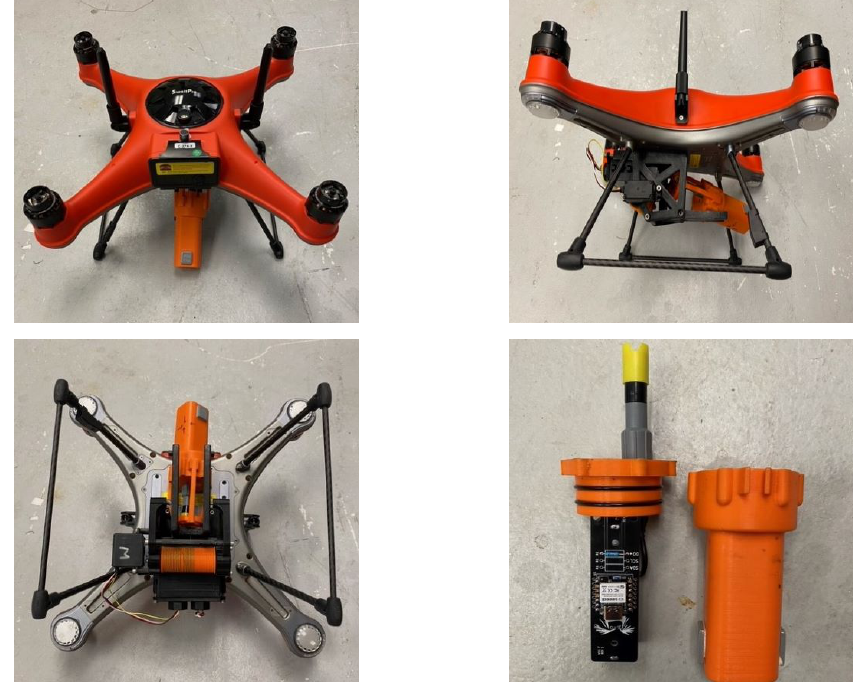
Figure 5. ( Top Left ) SwellPro SplashDrone 4 with orange payload visible underneath. ( Top Right ) Side view with the winch release mechanism and radio housing in black. ( Bottom Left ) Underside with the orange winch drum visible. ( Bottom Right ) Payload which contains BLE transmitter and DO, temperature and pressure sensors.